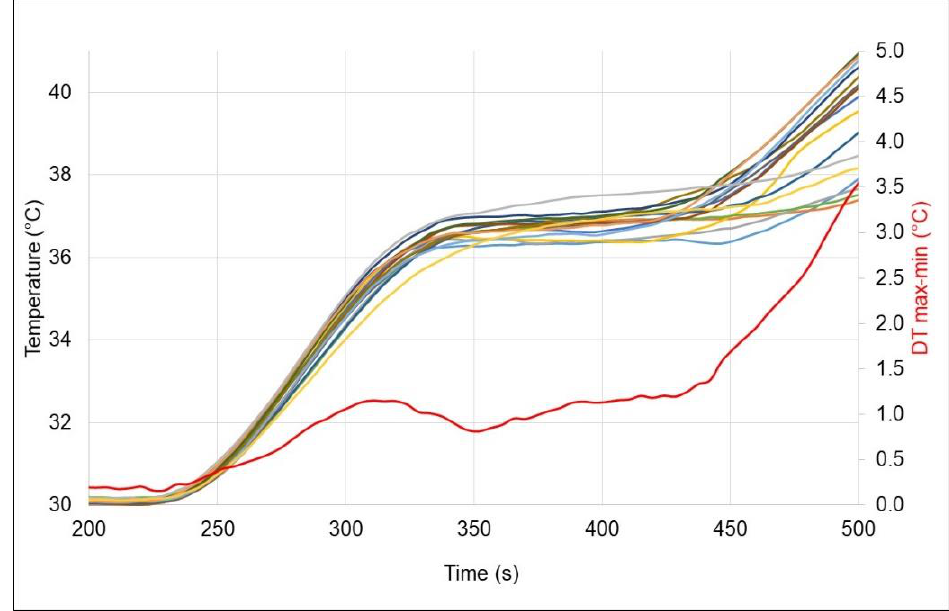
Figure 16. Wall temperature of the cells during an experimental run with a thermal dissipation of P = 6.6 W per cell.